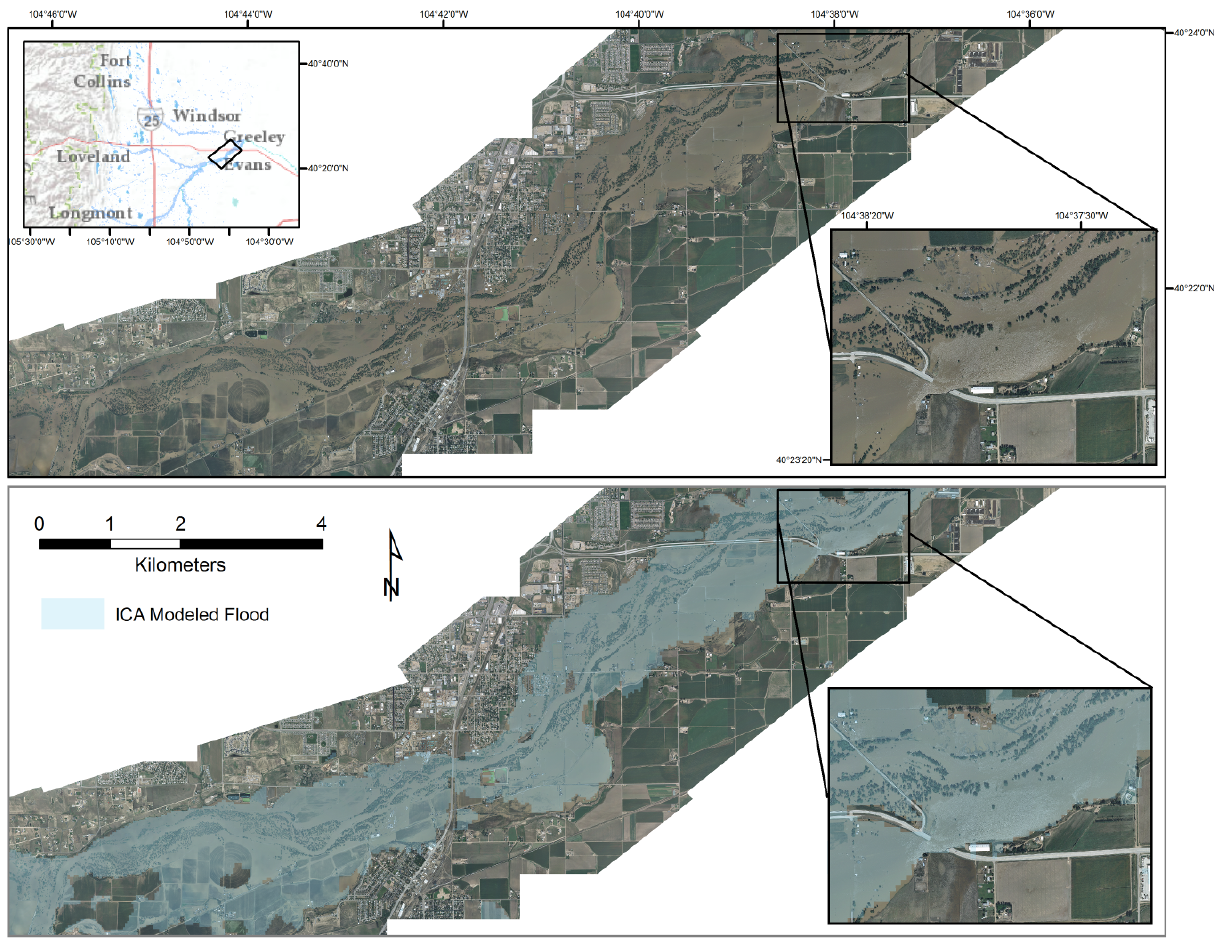
Figure 4. ( Top ) Orthophotographs of the South Platte River near Evans, Colorado. The main river channel is visible near the center of the floodplain, which is heavily inundated with floodwater (light brown). Residual moisture and pools of water can be seen near the center-pivot crop circle in the lower left corner. ( Bottom ) The ICA modeled flood layer overlaying the aerial imagery from the top image. Insets show detailed view of water and sediment flowing over U.S. Route